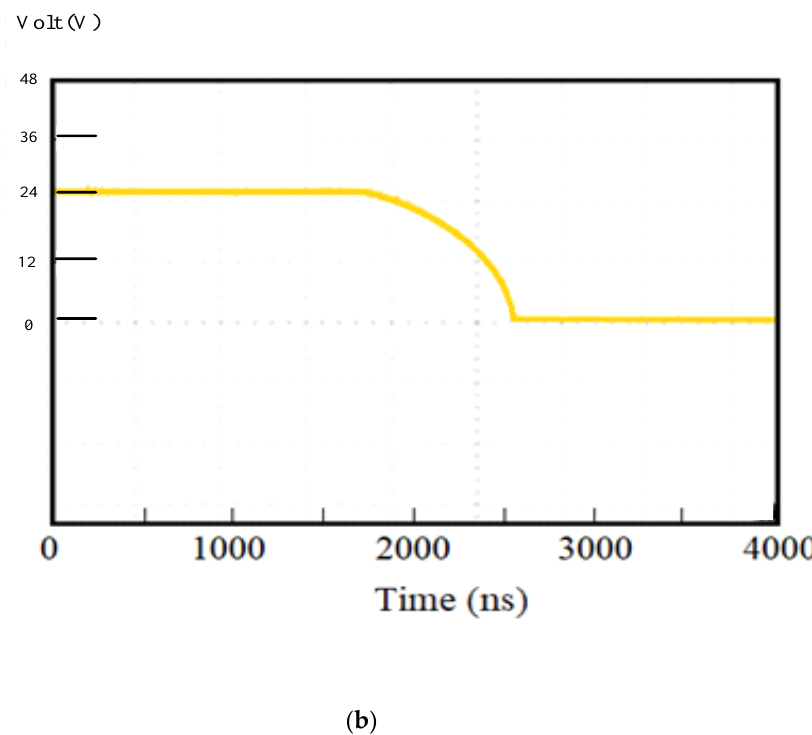
Figure 18. Measured voltage responses of relay. ( a ) off, ( b ) on.